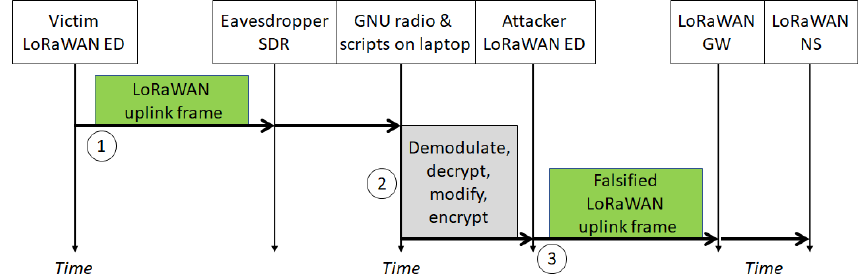
Figure 6. Replay attack time sequence and phases.